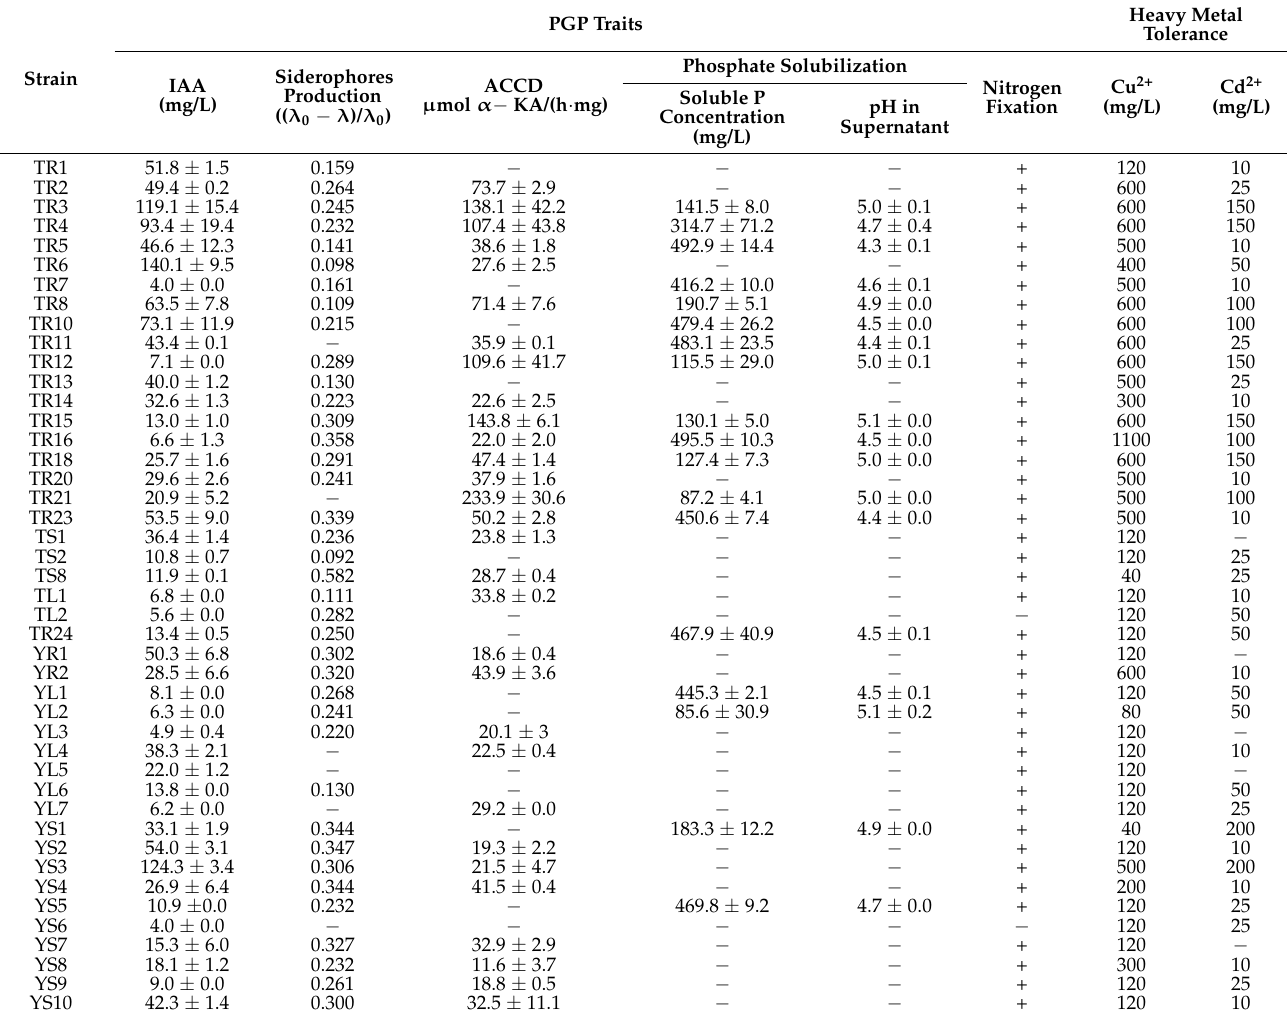
Table 3. Plant growth − promoting traits and heavy metal tolerance for isolated endophytic bacteria strains. PGP Traits Heavy Metal Strain